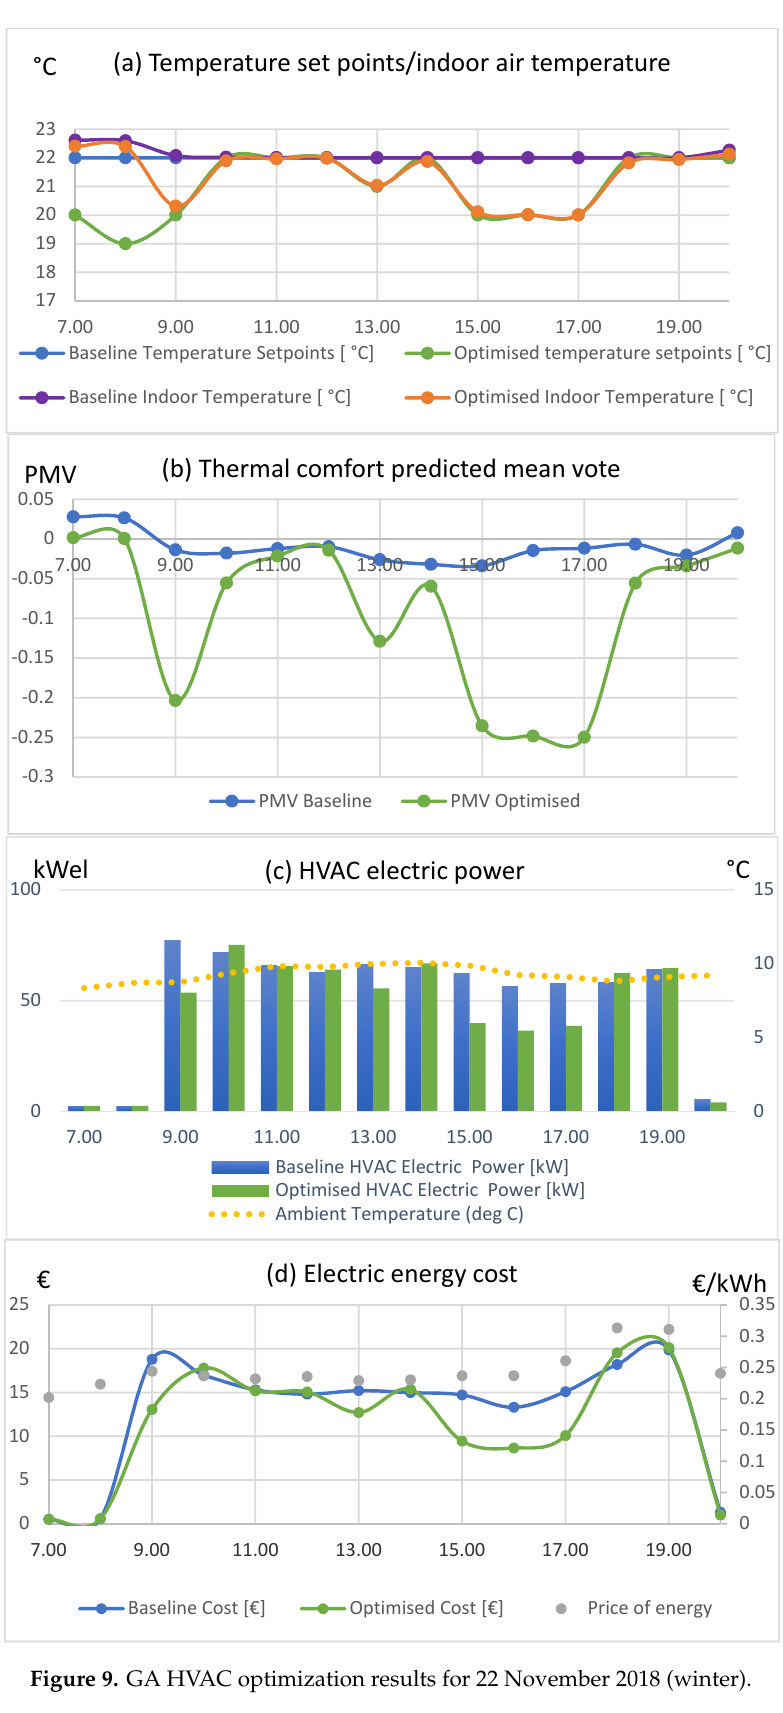
Figure 9. GA HVAC optimization results for 22 November 2018